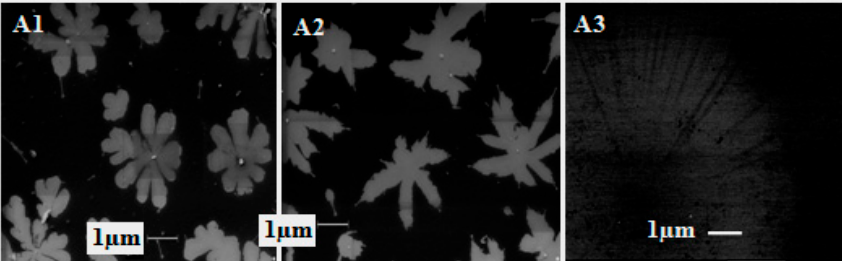
Figure 9 . The FEGSEM pictures of three alumina–silica preform samples of EDF: phase-separated ( A1 and A2 ) and non-phase-separated ( A3) .